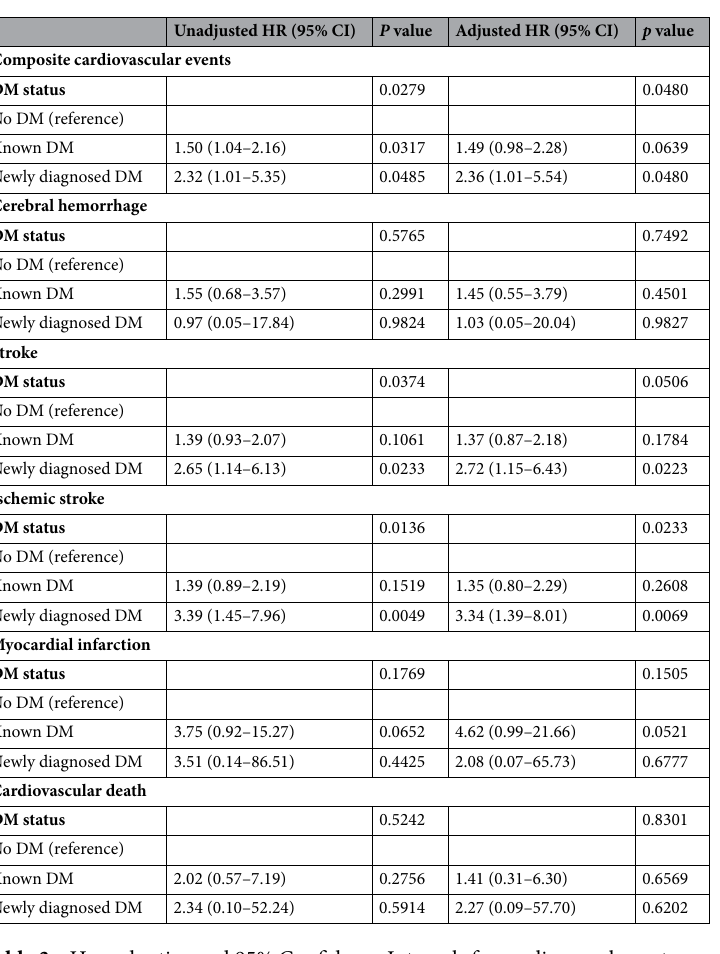
Table 3. Hazard ratios and 95% Confidence Intervals for cardiovascular outcome by diabetes status. Hazard ratio adjusted for hypertension, dyslipidemia, body mass index, Glucose, Triglyceride, HDL and NIHSS score. DM Diabetes mellitus, HR hazard ratio, CI confidence interval.